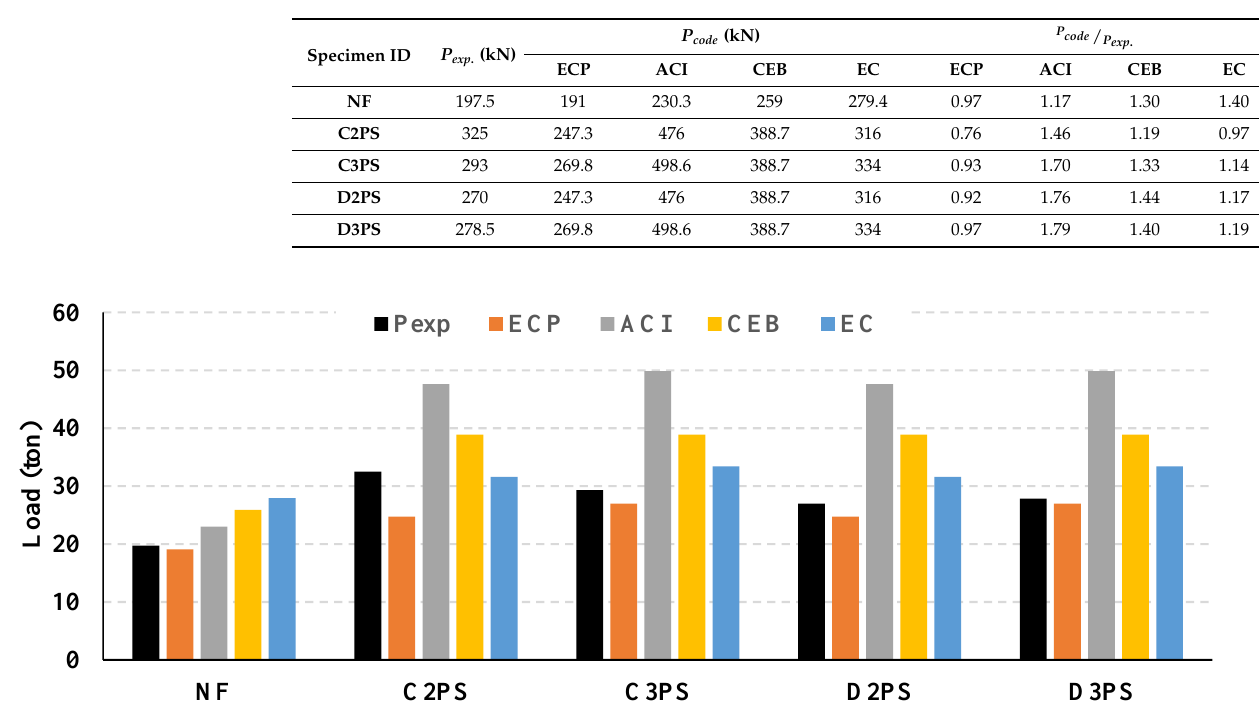
Table 8. Calculated P from different codes and the percentage between P code and P actual from experi- mental lab.